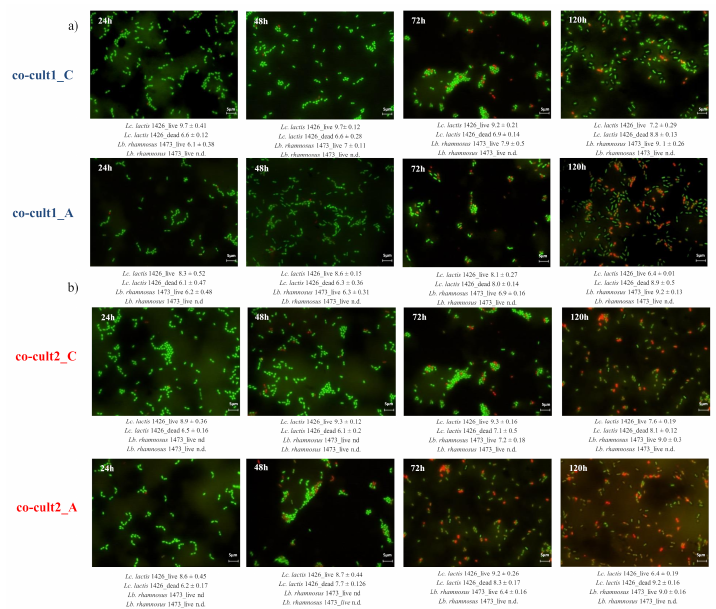
Figure 4. Fluorescence microscopy images of co-culture 1 ( a ) and co-culture 2 ( b ), with (co-Cult_A) and without (co-cult_C) 0.3% of antimicrobial A. platensis extract at four sampling time points: 24, 48, 72, and 120 h of incubation. Live cells labelled with Syto 9 appear in green, and dead cells labelled with propidium iodide (PI) appear in red. Scale bars are 5 µ m in length. The Starter strain cells Lc. 1426 are round-shaped, while the non starter strain cells Lb. 1473 are